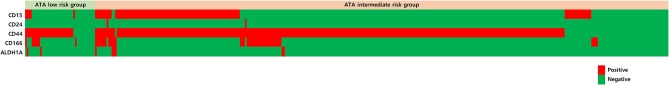
Heat map of cancer stem cell markers expressed in papillary thyroid carcinoma with ATA low risk and ATA intermediate risk.